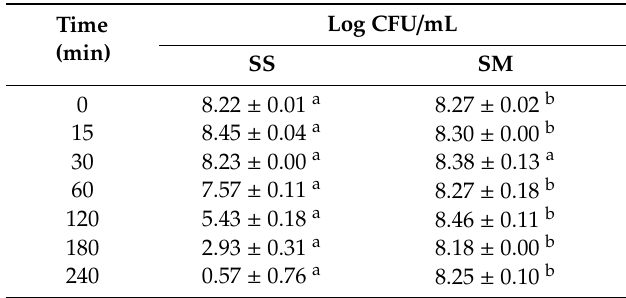
Table 1. Viable cells of Lactococcus lactis subsp. cremoris LL95 when submitted to simulated gastric